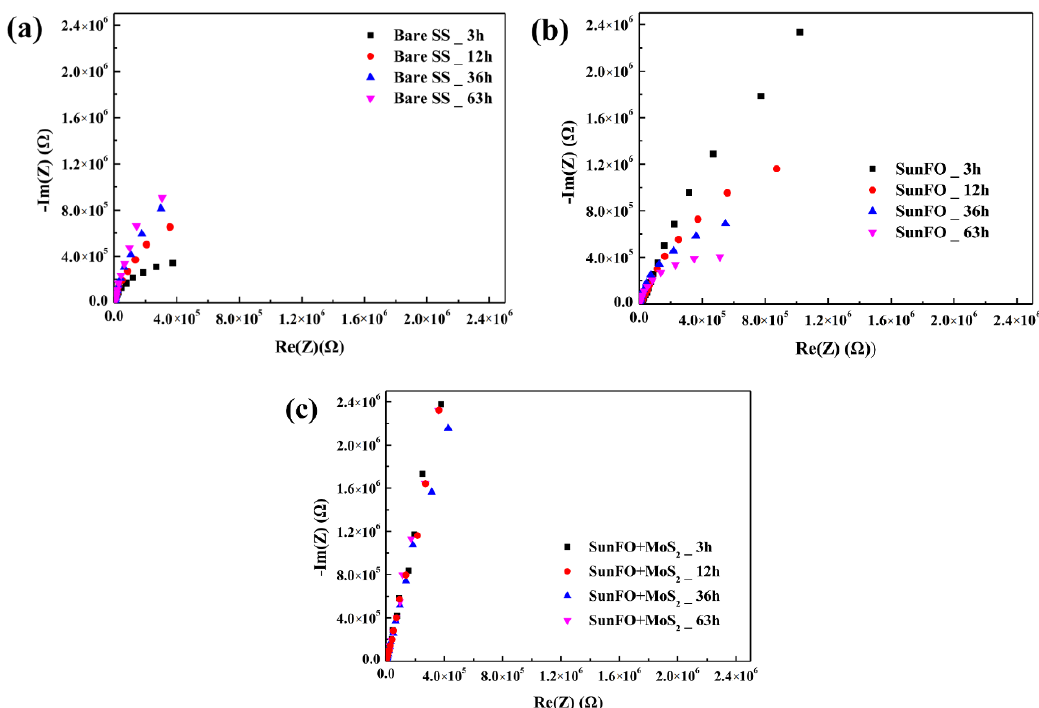
Figure 6. Electrochemical impedance spectroscopy (EIS) results in the form of Nyquist plot in 3.5% NaCl solution; ( a ) Bare SS; ( b ) SunFO coated SS; ( c ) SunFO + MoS 2 coated SS.